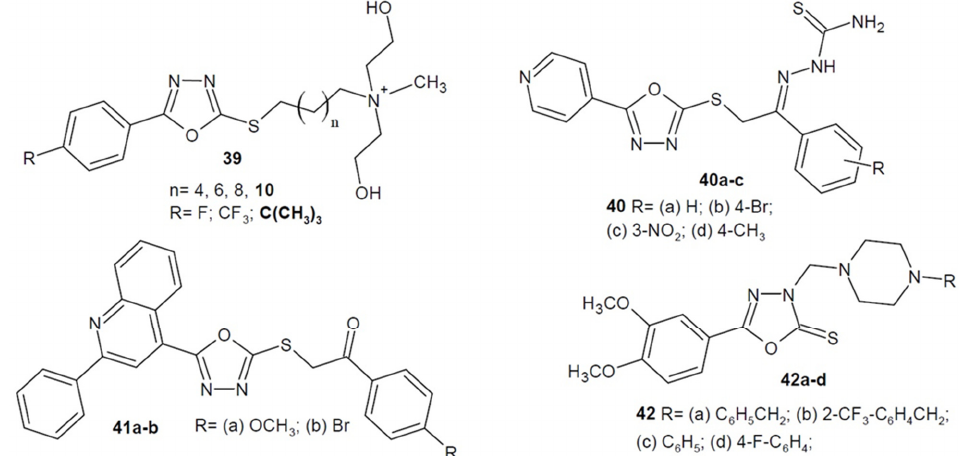
Figure 15. 1,3,4-oxadiazole-2-thiones/thiols and their S -substituted derivatives with antibacterial activity (part 2).